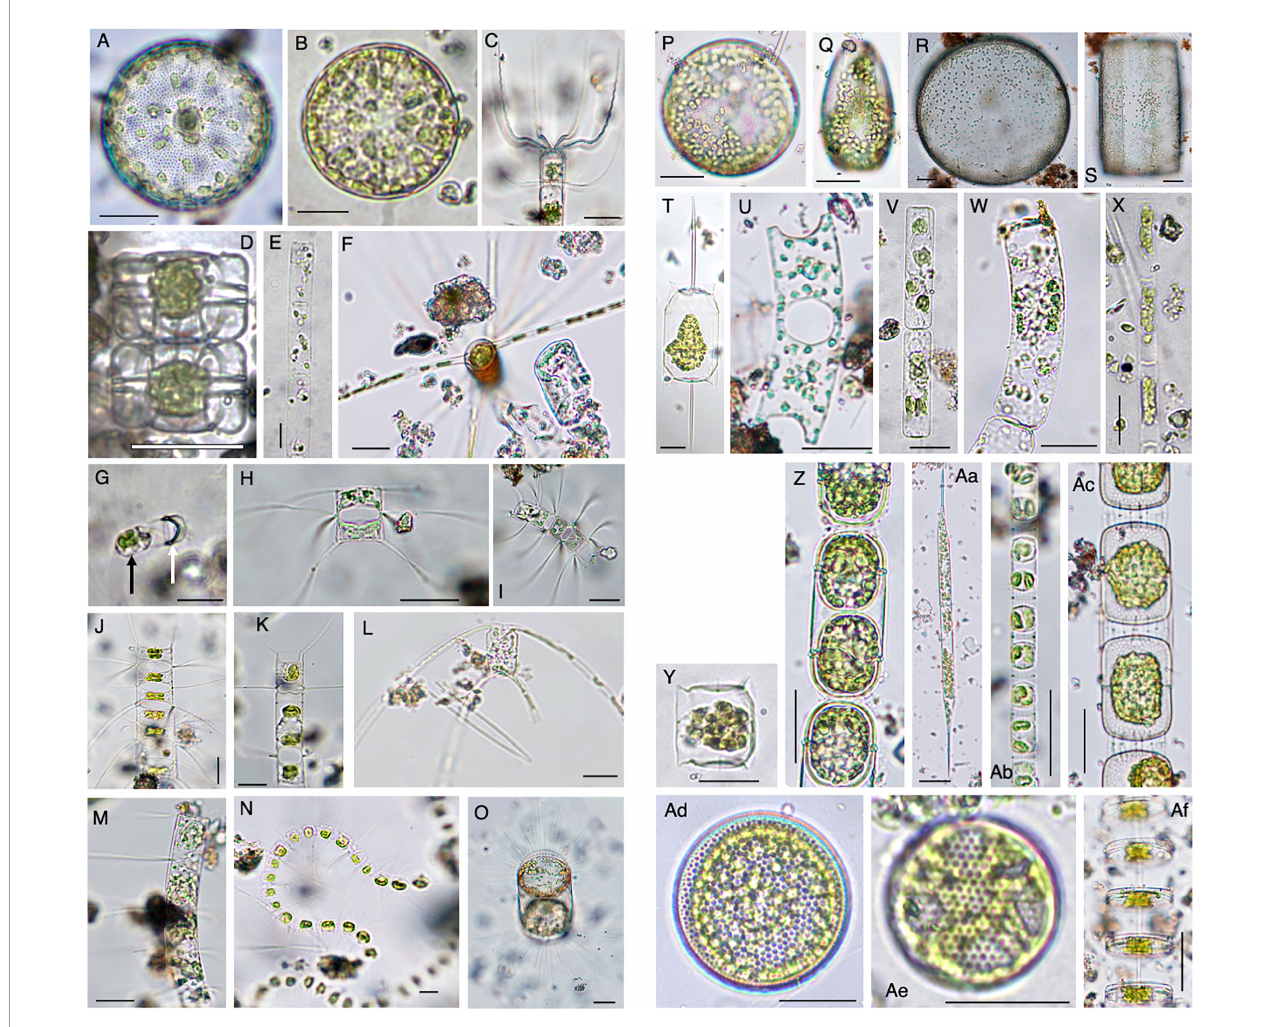
FIGURE 7 | Photomicrographs showing representative centric diatoms that emerged in the PET chamber. Actinocyclus sp. (A) , Actinoptychus senarius (B) , Bacteriastrum elongatum (C) , Biddulphia alternans (D) , Cerataulina pelagica (E) , Chaetoceros danicus (F) , Chaetoceros debilis (G – I) , Chaetoceros didymus (J) , Chaetoceros distans (K) , Chaetoceros peruvianus (L) , Chaetoceros pseudocurvisetus (M) , Chaetoceros socialis (N) , Corethron pennatum (O) , Coscinodiscus granii (P, Q) , Coscinodiscus wailesii (R, S) , Ditylum brightwellii (T) , Eucampia zodiacus (U) , Guinardia delicatula (V) , Guinardia striata (W) , Leptocylindrus danicus (X) , Lithodesmium variabile (Y) , Melosira nummuloides (Z) , Rhizosolenia setigera (Aa) , Skeletonema sp. (Ab) , Stephanopyxis palmeriana (Ac) , Thalassiosira spp. (Ad – Af) . In (G) , black and white arrows indicate a vegetative cell just after germination and a valve of the resting spore, respectively. Scale bars: 50